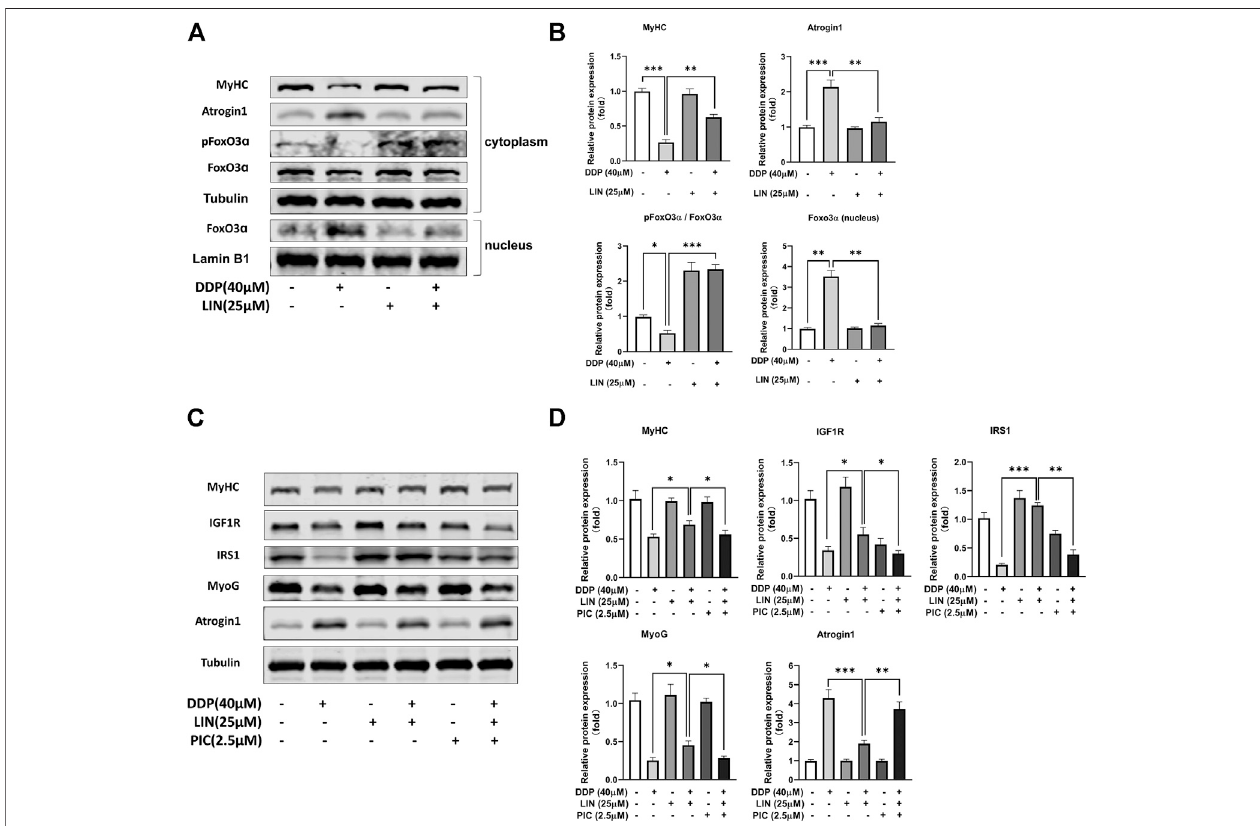
FIGURE 6 | LIN prevented FoxO from entering nucleus and alleviated muscle atrophy in DDP treated C2C12 myotubes, which could be blocked by IGFR inhibitor PIC (A) CytoplasmproteinexpressionofMyHC,Atrogin1,pFoxO3 α ,Foxo3 α wasevaluatedbywesternblotting,Tubulinwasusedasaninternalcontrol.Nucleusprotein expressionofFoxo3 α wasevaluatedbywesternblotting,LaminB1wasusedasaninternalcontrol. (B) Therelativeexpressionlevelsoftheproteinswerequanti fi edusing ImageJ software, the cytoplasm protein relative expression levels were normalized to Tubulin and corrected to the untreated group, the nucleus protein relative expression levelswerenormalized toLaminB1andcorrectedtotheuntreated group. (C) Theproteinexpression ofMyHC,IGF1R, IRS1,MyoG, Atrogin1wasevaluated by western blotting, Tubulin was used as an internal control. (D) The relative expression levels of the proteins were quanti fi ed using ImageJ software and normalized to Tubulin and corrected to the untreated group. Data shown as mean ± S.E.M. (n (cid:2) 3); * p < 0.05, ** p < 0.01, *** p < 0.001.